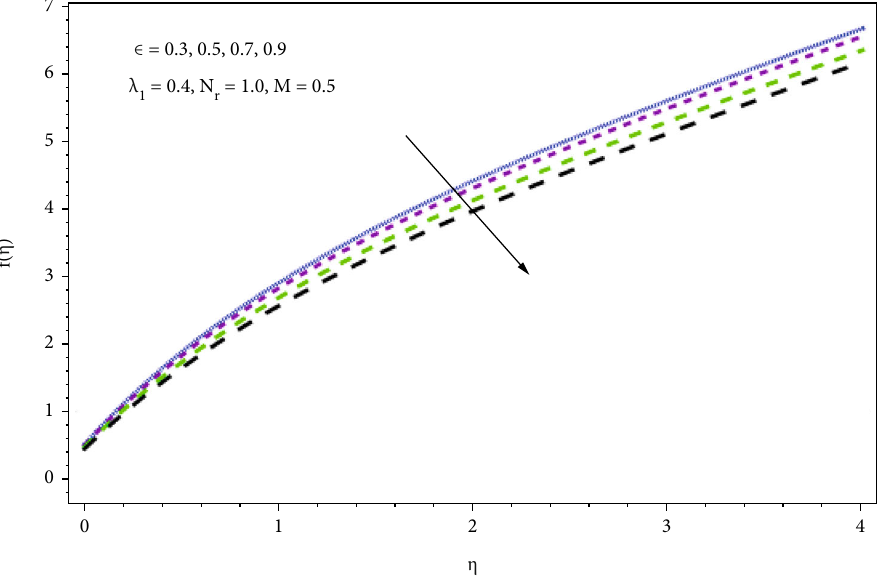
Figure 3: Representation of the e ff ect of ε on f ′ ð η Þ .